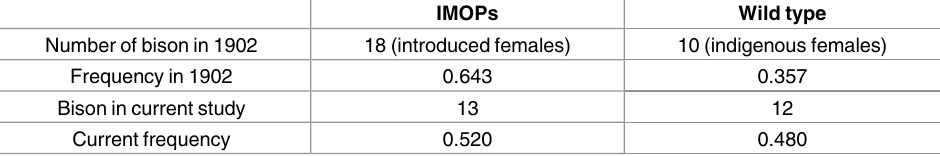
Table 3. Historic and present frequencies of IMOP mutations in Yellowstone